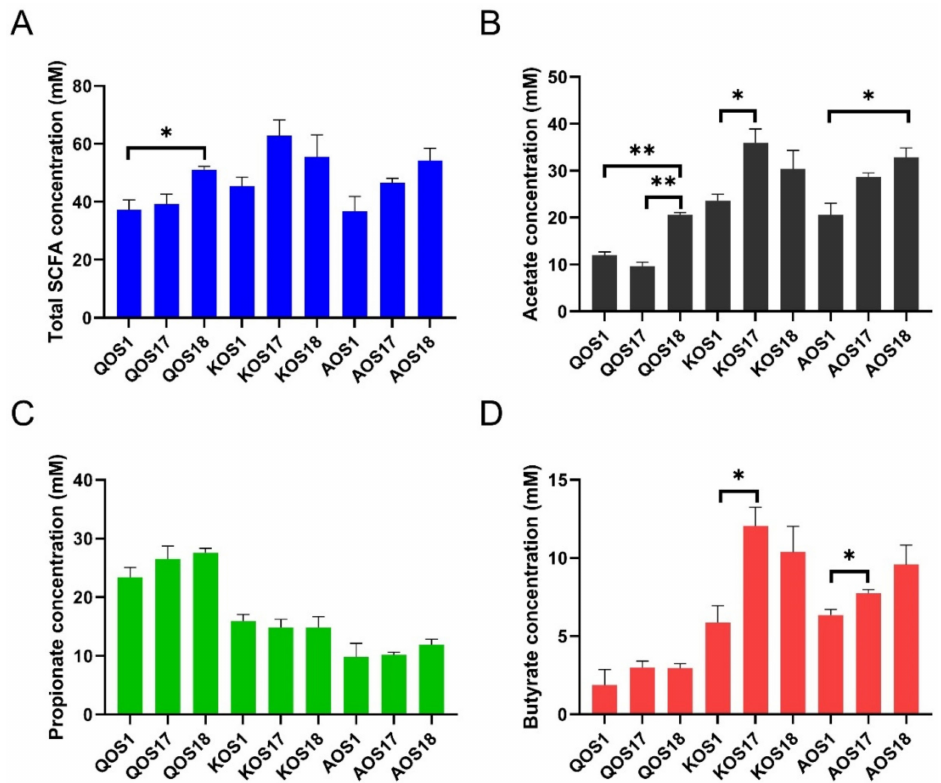
Figure 7. Production of short-chain fatty acid (SCFA) by three different enterotypes of human microbiota during fermentation of QOS, KOS, and AOS. The concentrations of total SCFA ( A ), acetate ( B ), propionate ( C ), and butyrate ( D ) were analyzed. QOS1 denotes fermentation of QOS by gut microbiota F1. QOS17 denotes fermentation of QOS by gut microbiota F17. QOS18 denotes fermentation of QOS by gut microbiota F18. Each fermentation group has three replicates. KOS and AOS were labeled using the same format. Data are expressed as mean ± SEM. Statistical analysis was performed using ANOVA with post hoc Tukey’s multiple comparisons test. * p < 0.05, ** p <